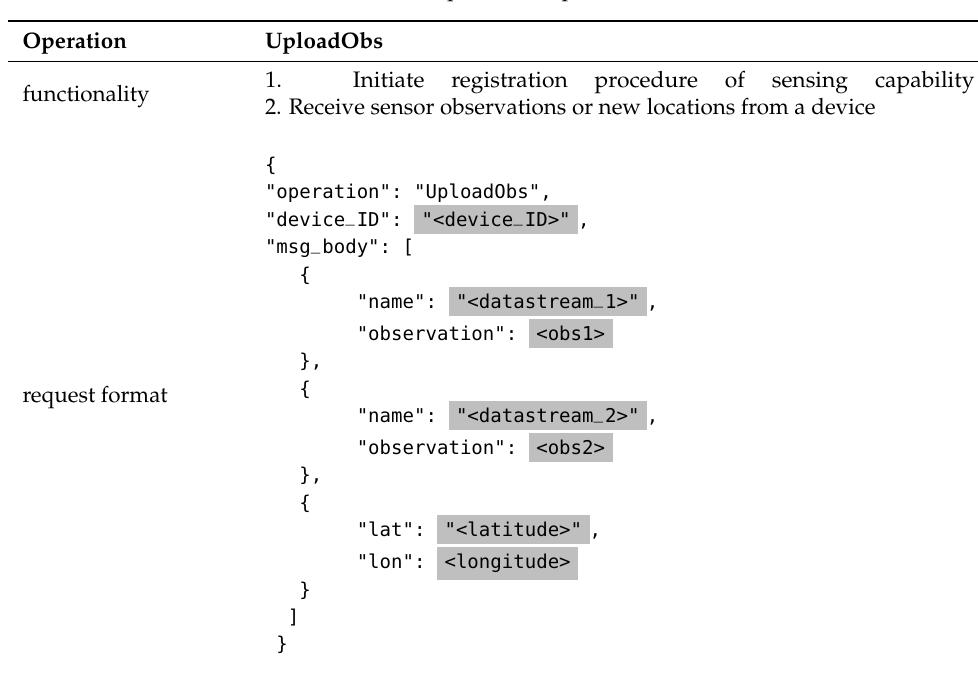
Table 3. UploadObs